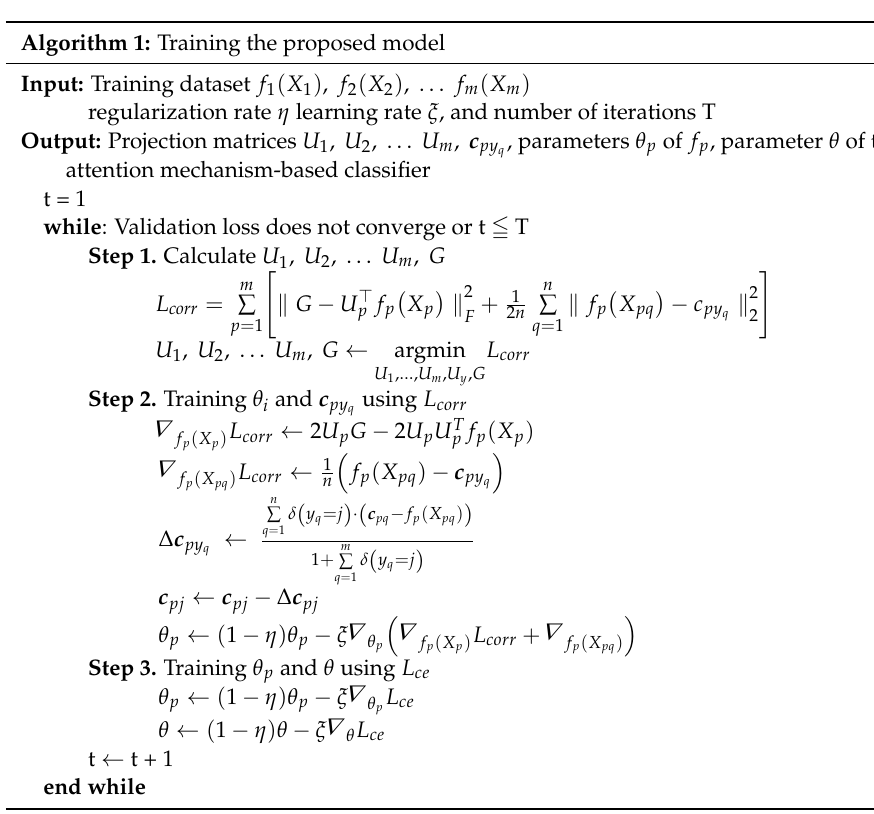
Algorithm 1: Training the proposed model